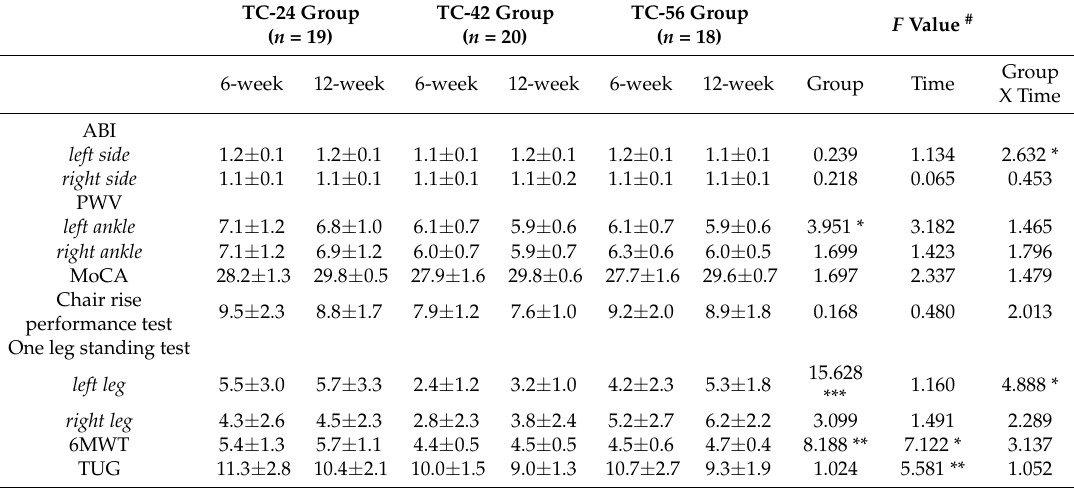
Table 2. Descriptive statistics of all outcome variables across groups at mid-term (Week 6) and post (Week